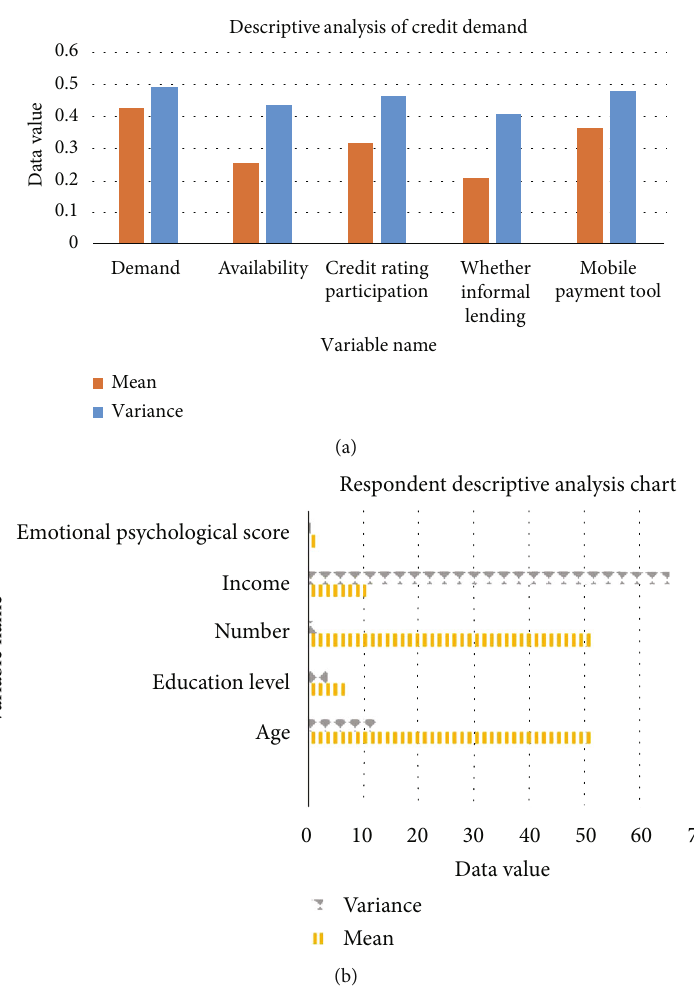
Figure 6: The detailed situation map of the investigated persons; (a) the credit behavior distribution map; (b) the identity map of the investigated persons.